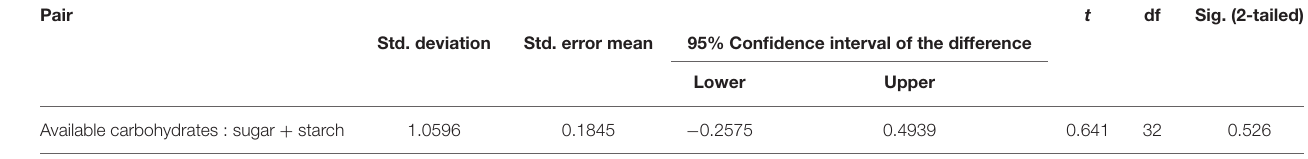
TABLE 4 | Paired sample T -Test for testing significant differences between available carbohydrate and sum of sugar and starch. Pair df